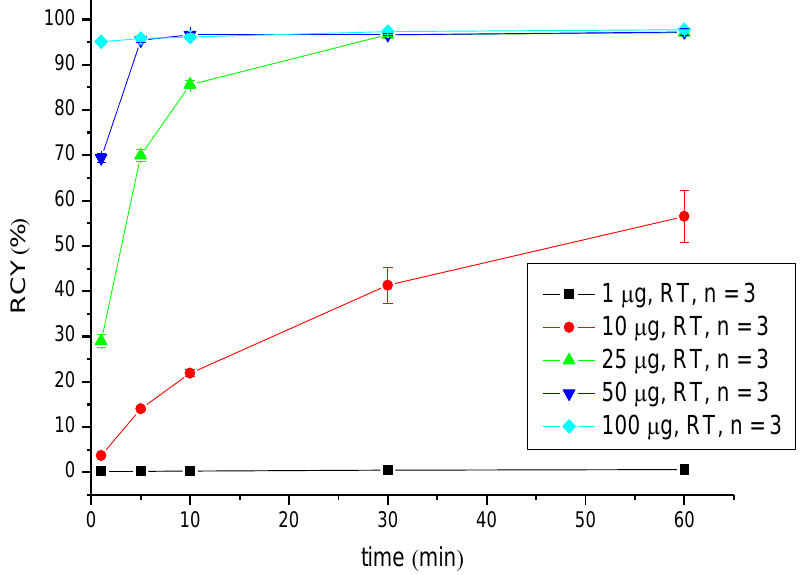
Figure 2. Dependence of the RCY of [ 68 Ga]Ga-CHX-A''-DTPA-DUPA-Pep on the peptide amount (concentration) and reaction time at room